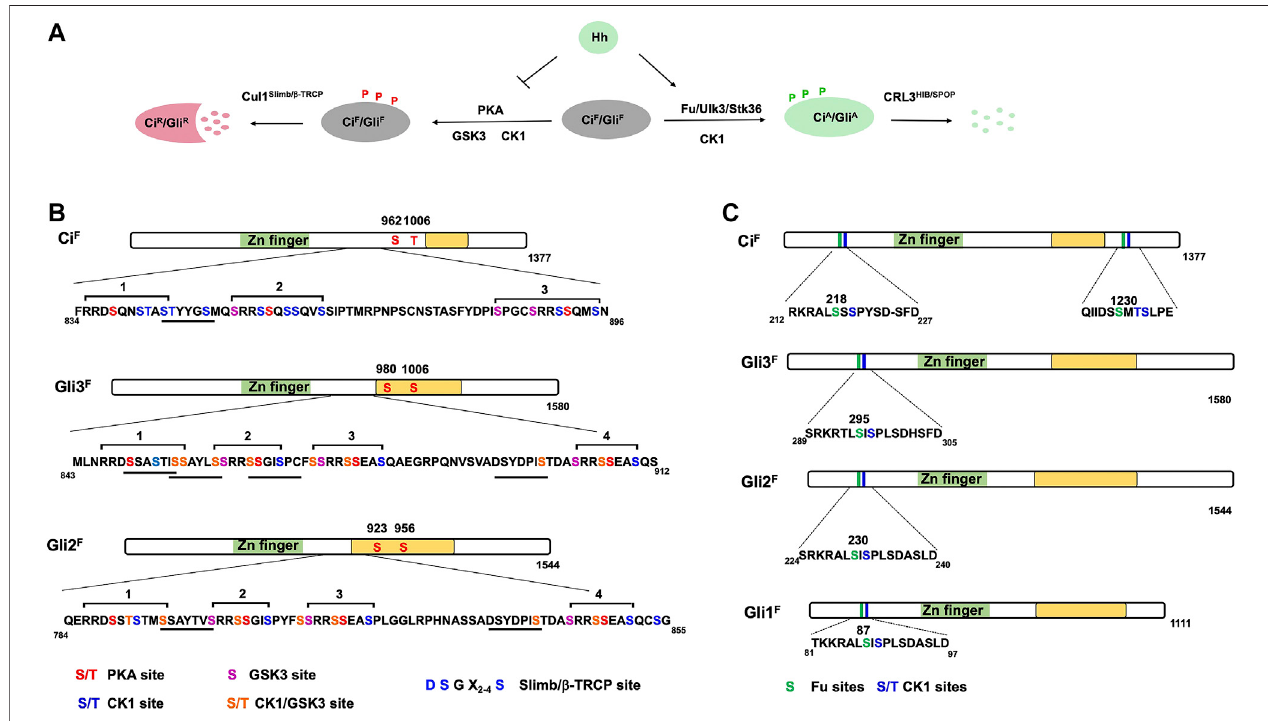
FIGURE 2 | Ci/Gli phosphorylation code. (A) Ci/Gli is phosphorylated on different sites by distinct sets of kinases depending on the Hh signaling states. In the absence of Hh, phosphorylation of Ci F /Gli F by PKA/CK1/GSK3 negatively regulates Hh signaling by converting Ci F /Gli F into Ci R /Gli R whereas in the presence of Hh, phosphorylationofCi F /Gli F byFu/Ulk3/Stk36playsapositiverolebypromotingtheformationofCi A /Gli A . (B – C) SchematicrepresentationofCiandGlishowingthePKA/ CK1/GSK3 phosphorylation sites (B) and Fu/Ulk3/Stk36 phosphorylation sites (C) . Individual kinase sites are color coded. The underlines indicate the Slimb/ β - TRCP binding sites in Ci/Gli. The green box represents the Zn- fi nger DNA-binding domain whereas the yellow box indicates the transactivation domain.